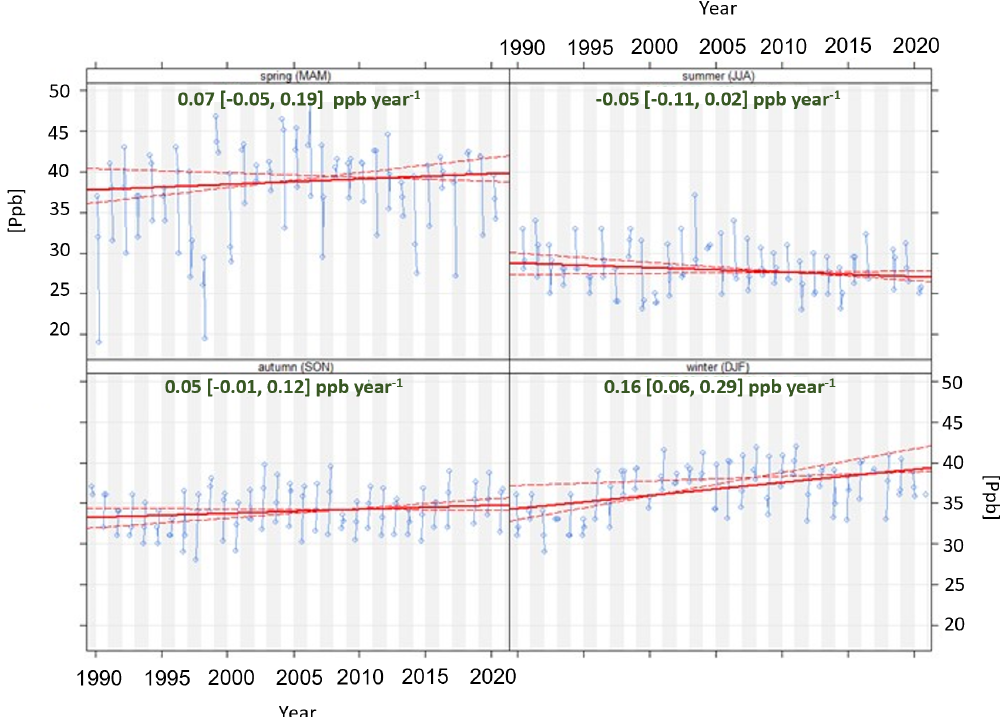
Figure 21. Theil–Sen slopes and confidence intervals for monthly median O 3 concentrations (ppb) at the Zeppelin Observatory during 1989 to 2020 for four seasons